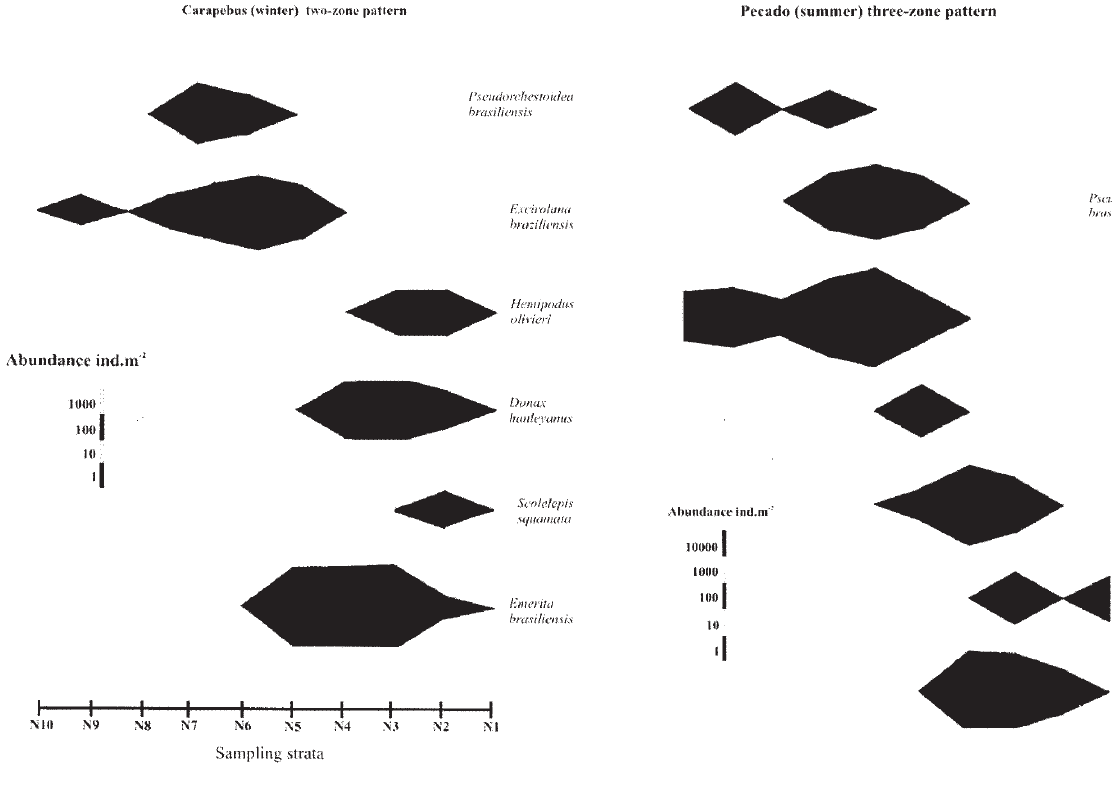
F IG . 3. – Diagram illustrating the two-zone pattern of macroinfauna zonation.